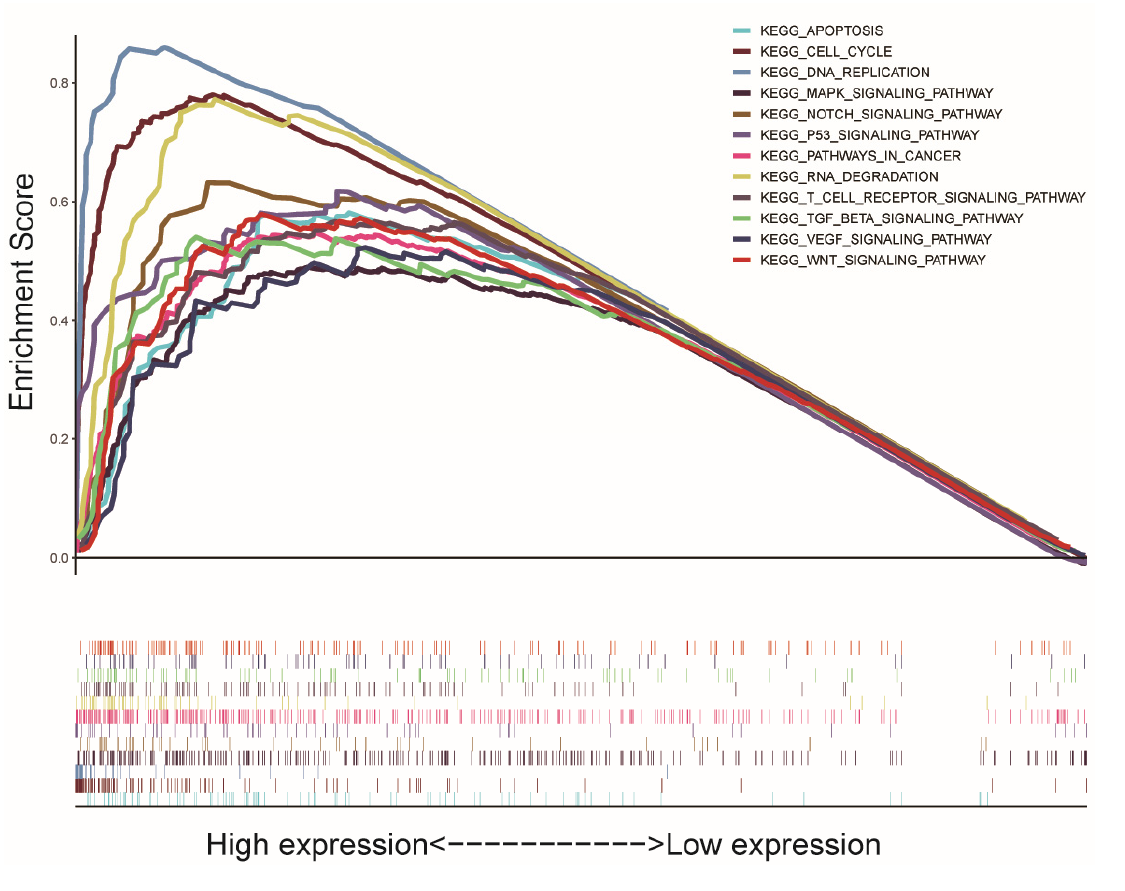
Figure 4. A merged enrichment plot from the gene set enrichment analysis, including the enrichment score and gene sets. The significantly enriched signaling pathways were apoptosis, cell cycle, DNA replication, the MAPK signaling pathway, NOTCH signaling pathway, P53 signaling pathway, pathways in cancer, RNA degradation, T-cell receptor signaling pathway, TGF- β signaling pathway, VEGF signaling pathway, and Wnt signaling